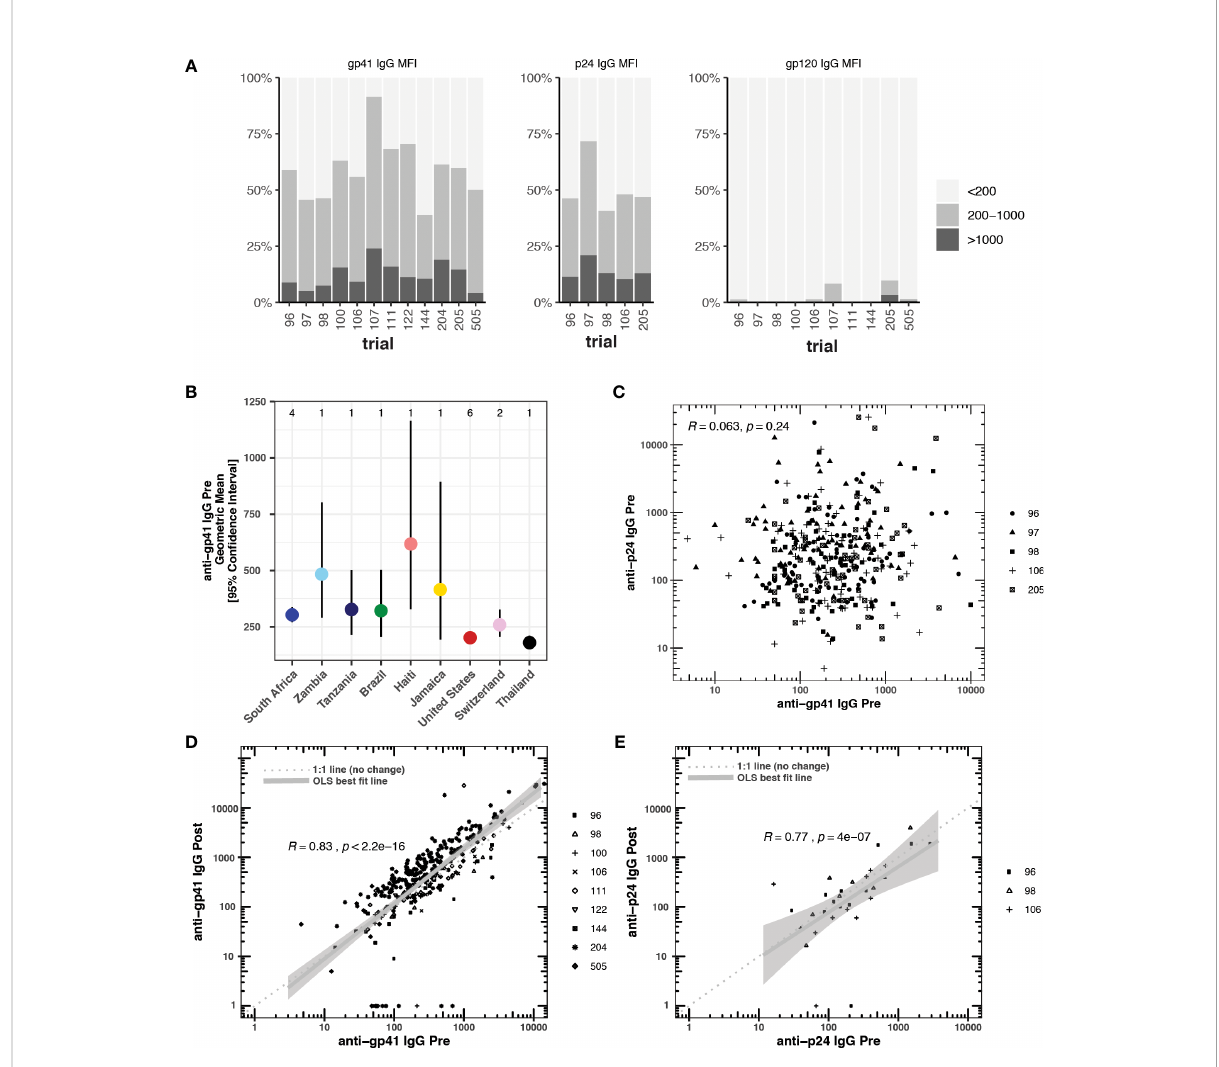
FIGURE 1 (A) Blank bead subtracted pre-vaccine cross-reactive anti-gp41, anti-p24, and anti-gp120 IgG responses measured by BAMA (mean fl uorescence intensity, MFI) prior to vaccination in 12 HTVN trials. Responders with blank bead signals greater than 500 MFI were excluded from the analysis. (B) Country-level geometric means and 95% con fi dence intervals for pre-vaccine anti-gp41 IgG. The number of studies considered in each country is shown at the top of the plot. (C) Pre-vaccine anti-gp41 IgG vs pre-vaccine anti-p24 IgG, (D) Pre-vaccine anti-gp41 IgG vs. post-vaccine anti-gp41IgG in placebo recipients (n= 314). (E) Pre-vaccine anti-p24 IgG vs. post-vaccine anti-p24IgG in placebo recipients(n=